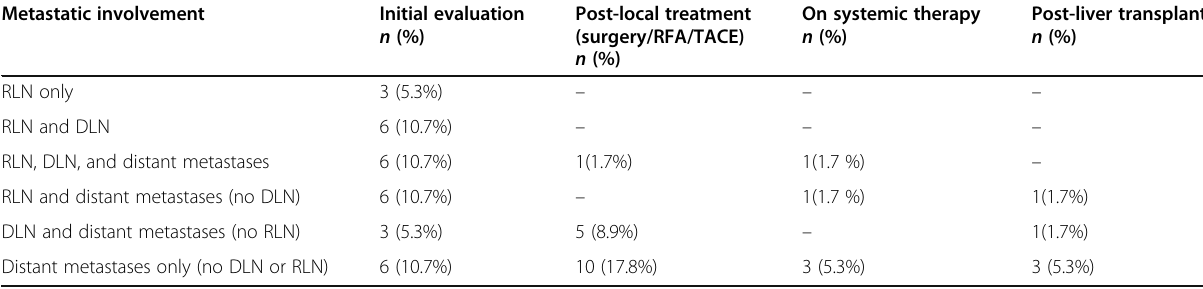
Table 11 Relative pattern of involvement of metastatic lesions across various categories of patients, n = 56 Metastatic